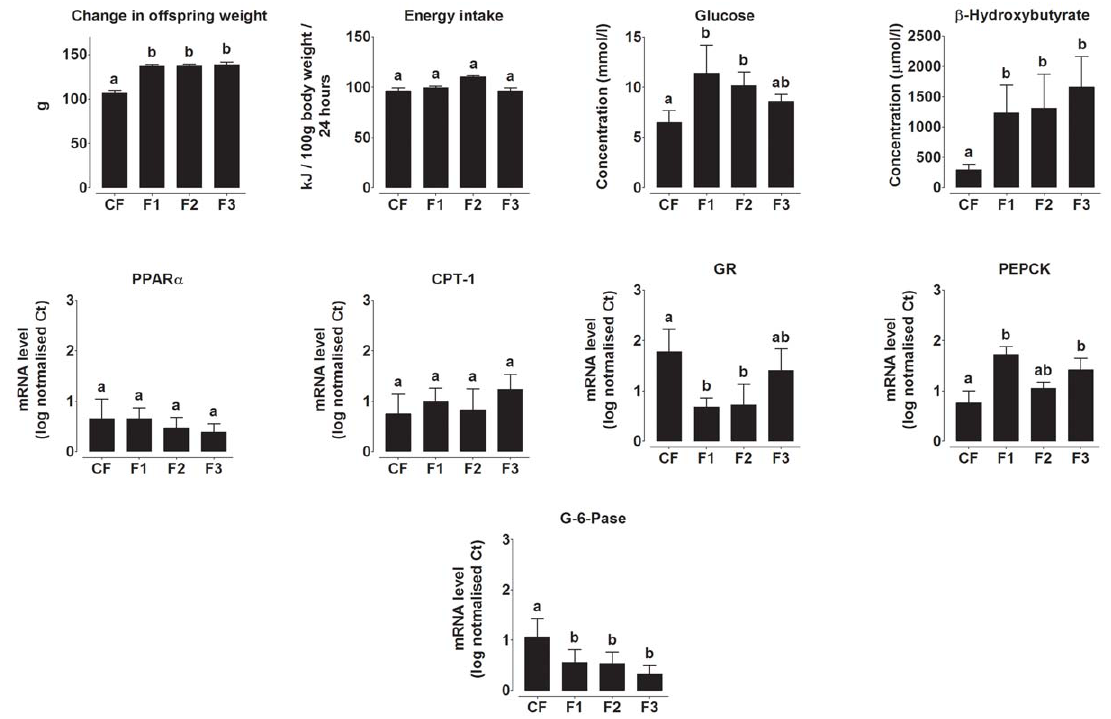
Figure 4. Offspring phenotype and mRNA expression of genes involved in hepatic gluconeogenesis and ketogenesis. Change in offspring body weight on day 70 compared to weaning, offspring energy intake on day 70, fasting glucose and b -hydroxybutyrate concentrations on postnatal day 70. Hepatic PPAR a , carnitine palmitoyltransferase-1 (CPT-1), glucocorticoid receptor (GR), phosphoenolpyruvate carboxykinase (PEPCK), (I) glucose-6-phosphatase (G-6-Pase) mRNA expression. Values are mean 6 SD for n=5 2 7 rats per group. Values with different letters are significantly different (P , 0.05).